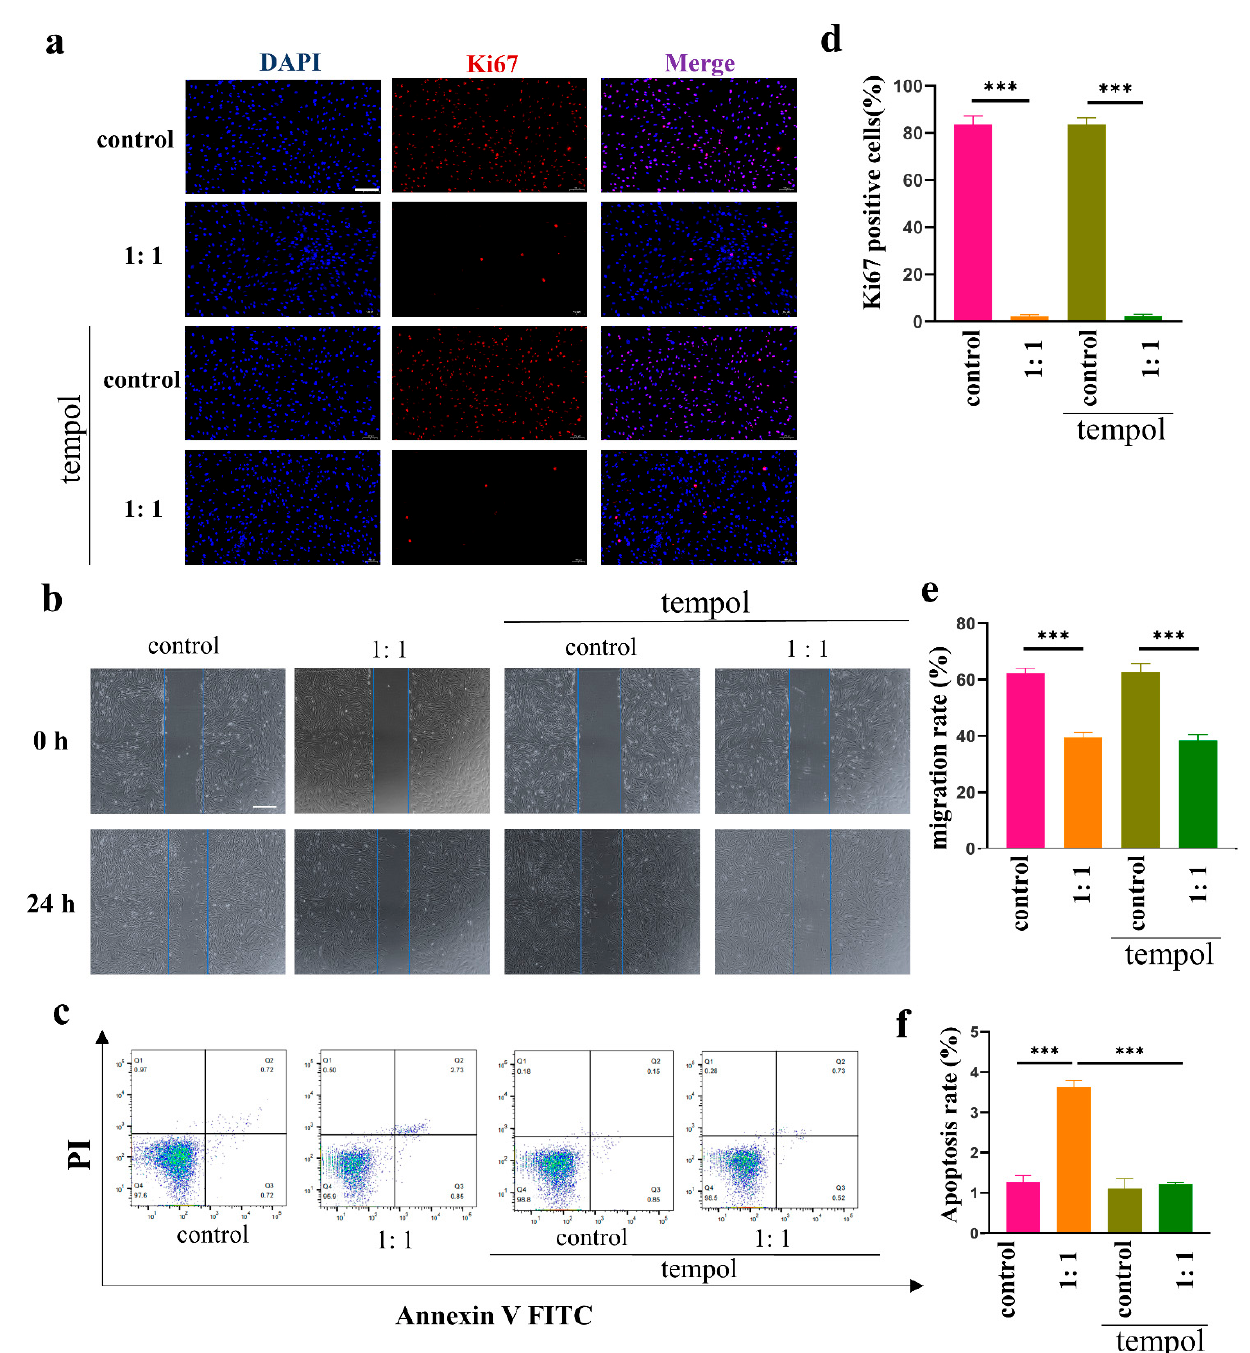
Figure 4. Proliferation, migration, and apoptosis of HSFs after ROS scavenging. ( a ) Immunofluorescence staining used to determine the expression levels of Ki67 in HSFs after coculturing with or without tempol, scale bar = 100 µ m. ( b ) Representative images of the cell scratch assay of HSFs after coculturing treated with or without tempol, scale bar = 200 μ m. ( c ) Examination of apoptotic cells in HSFs after coculturing with or without tempol. The apoptosis of cells was assessed through FACS after 24 h. ( d ) Quantitative analysis of the percentage of Ki67 positive cells as shown in a (n = 3). ( e ). Quantitative analysis of the migration rate in b (n = 3). ( f ) Quantitative analysis of the percentage of apoptotic cells as shown in c (n = 3).*** p < 0.001 vs.